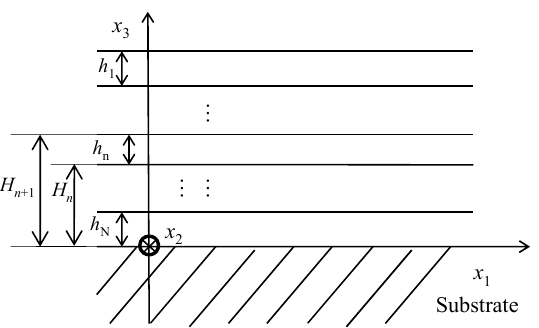
Figure 2. The coordination system in this